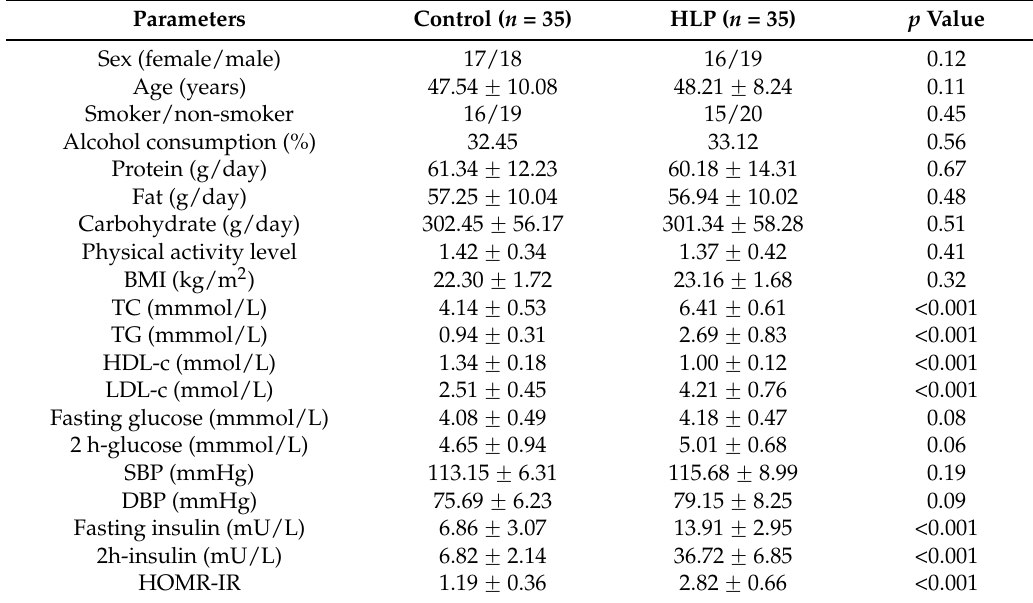
Table 1. Demographic and clinical chemistry characteristics of human